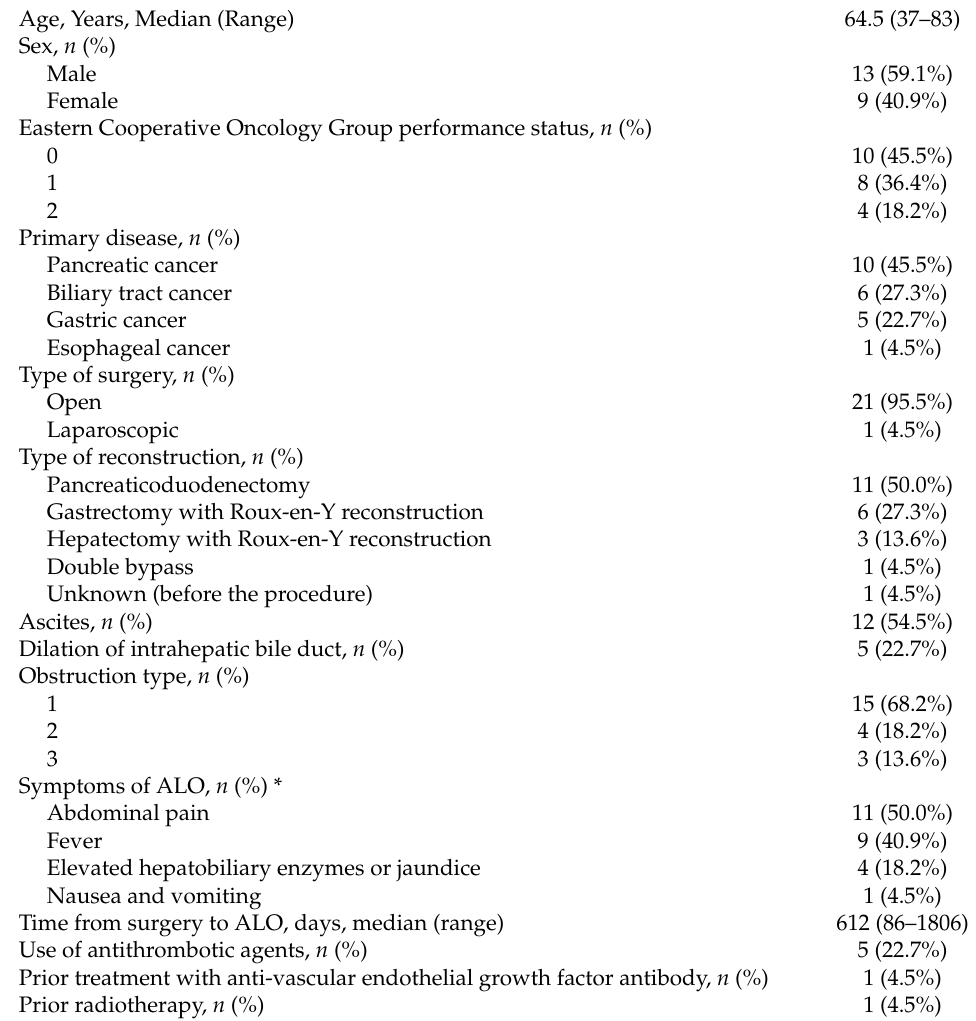
Table 1. Patient characteristics in Initial cohort ( n =